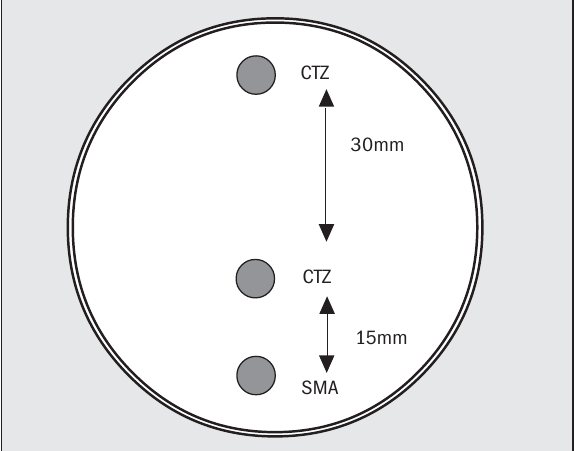
Figura 1 – Diagrama de colocação dos discos para o teste de disco aproximação usando-se